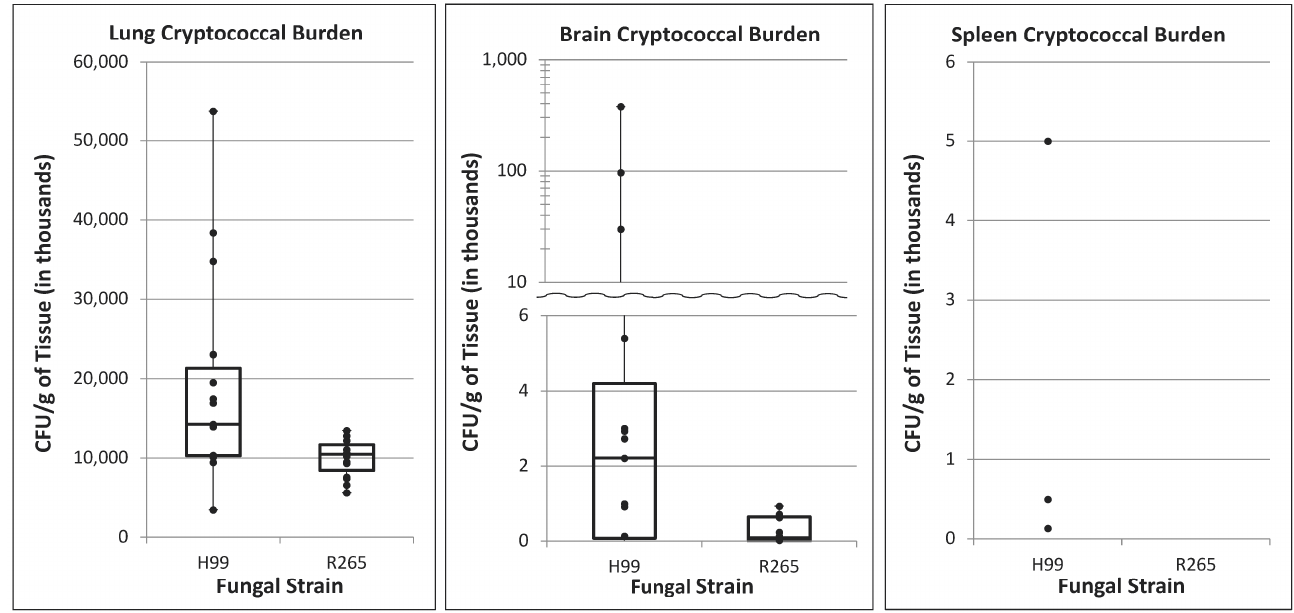
Figure 1. Fungal tissue burden in lungs, brain, and spleen. Fungal burden in lung, brain, and spleen tissues was measured for the two cohorts of infected mice at the time of sacrifice 14 days after inoculation.